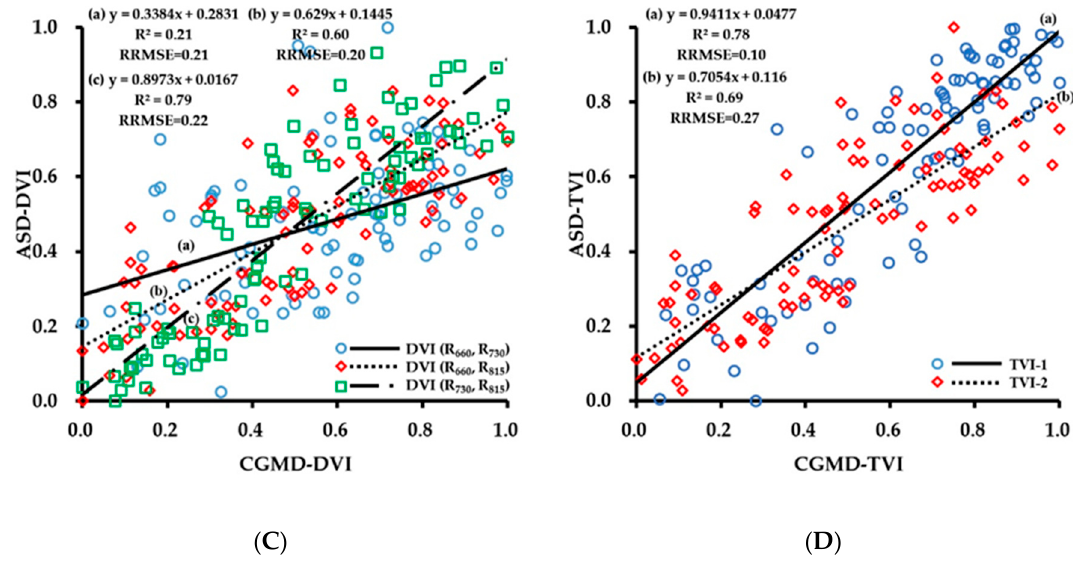
Figure 5. ( A ) Fitting curve of CGMD-NDVI and ASD-NDVI; ( B ) Fitting curve of CGMD-RVI and ASD-RVI; ( C ) Fitting curve of CGMD-DVI and ASD-DVI; ( D ) Fitting curve of CGMD-TVI and ASD-TVI.